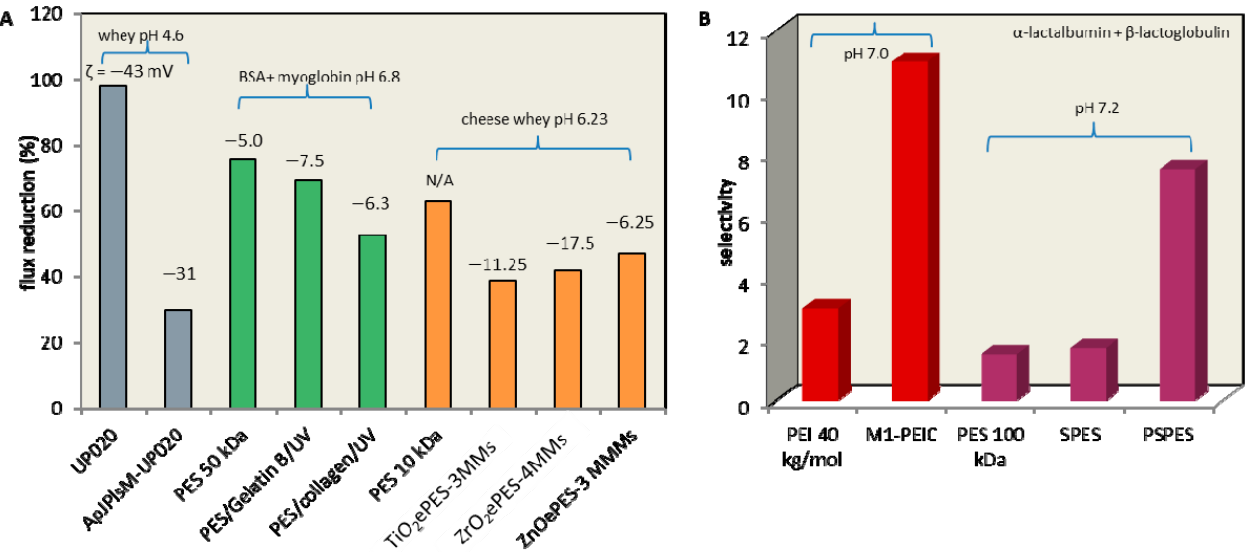
Figure 6. Performances of UF after selected surface modification ( A ) represented as flux reduction percentage and ( B ) selectivity. Data collected for ( A ) are from [189–191] and ( B ) from [186,188].